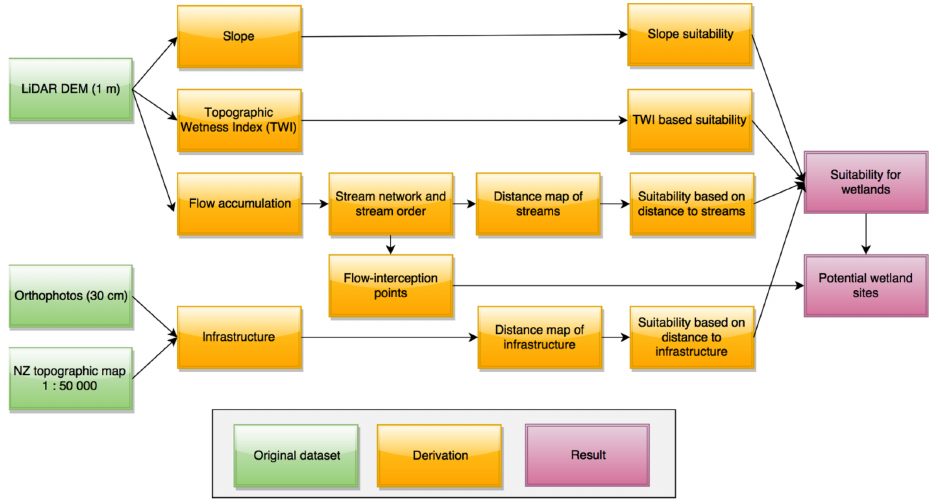
Figure 3. Workflow used for processing of the digital elevation model (DEM) data to generate suitability maps for mapping feasible locations for wetland construction or